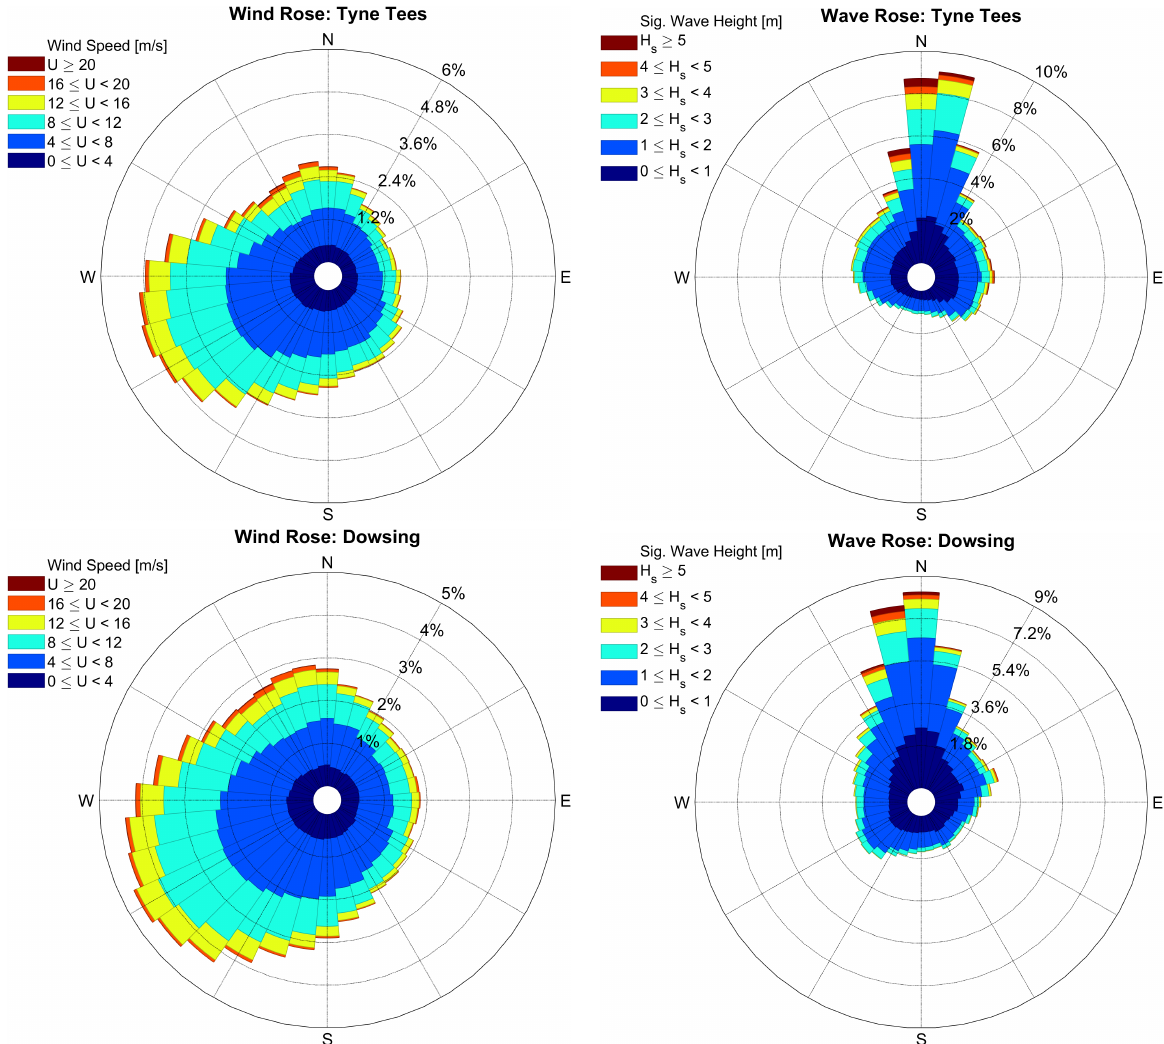
Figure 4. Wind and wave roses at Tyne Tees and